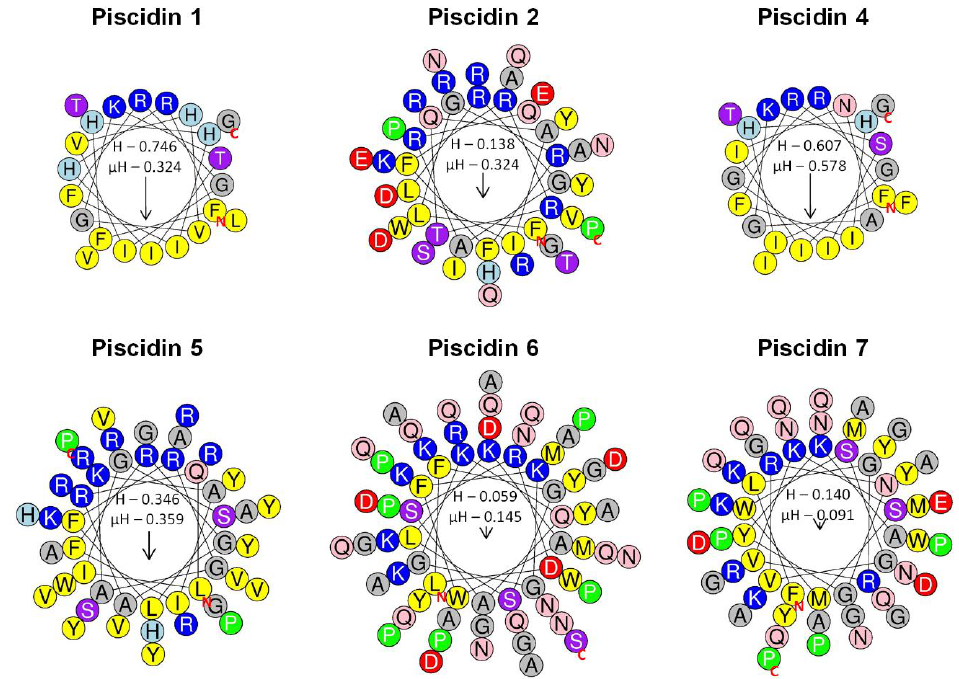
Figure 7. Schiffer–Edmundson helical wheel diagrams of sea bass piscidins. Piscidin 1, piscidin 2, piscidin 4, piscidin 5, piscidin 6 and piscidin 7. Positively charged residues are represented in blue circles, the negatively charged in red, the hydrophobic in yellow, the hydrophilic in purple, the amide in pink and the small residues in grey. Arrows indicate the direction of the hydrophobic moments. The red N and C represent the N-terminal and C-terminal of the peptide sequence. H represents peptide hydrophobicity, and µH represents the hydrophobic moment, which is a quantitative measure of amphipathicity.